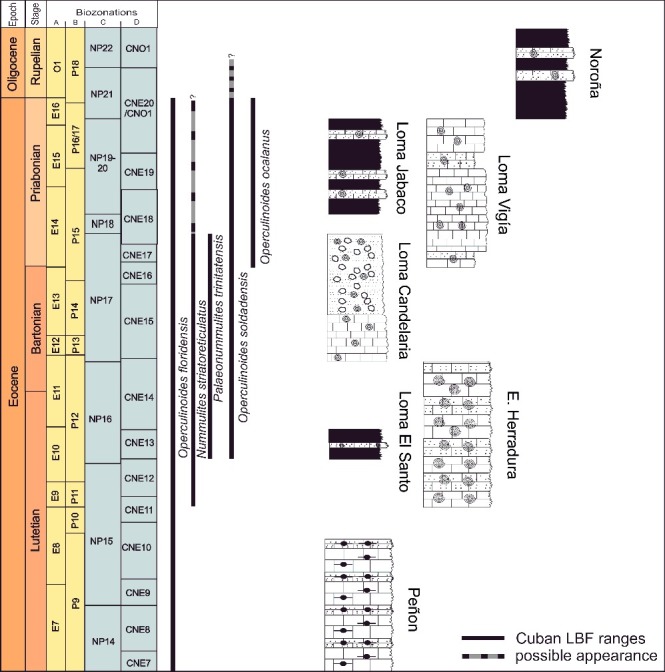
Stratigraphical ranges of the nummulitid species from the Cuban sections and their correlation with the standard planktonic zones. A, Pearson et al. (2006); B, Berggren et al. (1995); C, Martini (1971); D, Agnini et al. (2014).